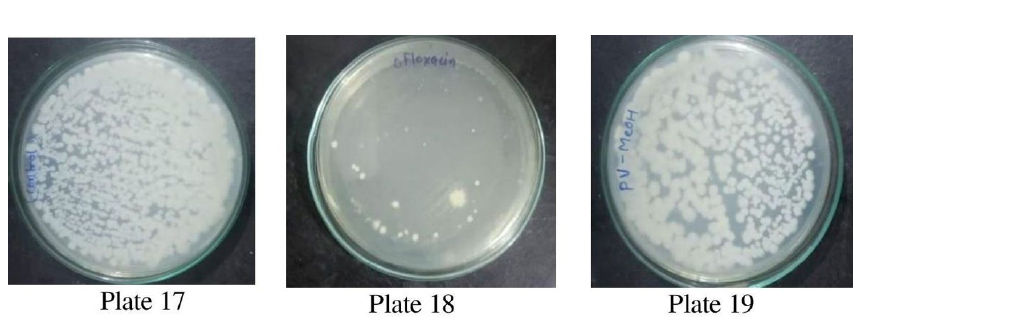
Fig. 13. Plate 17, 18 &19. In vivo bacterial clearance Control, Standard and